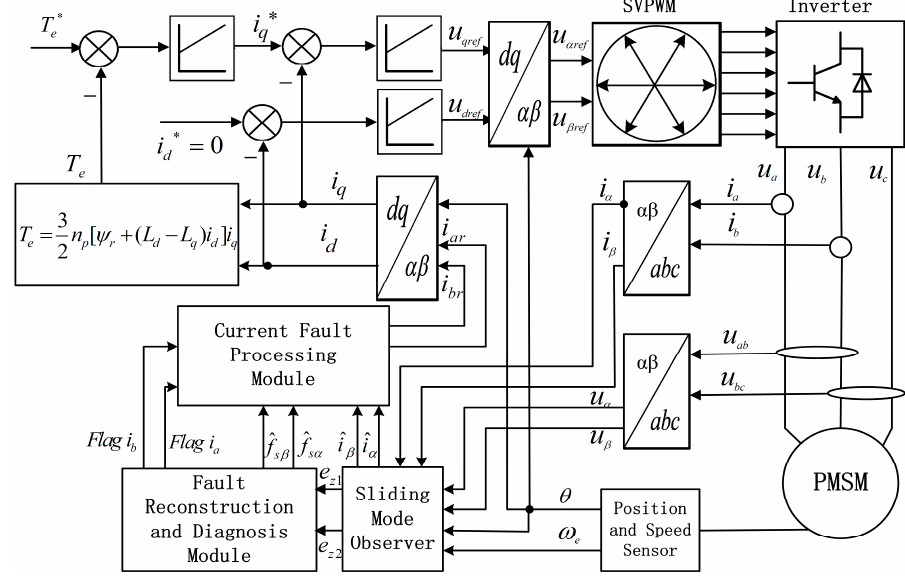
Figure 2. Block diagram of current sensor fault reconstruction and fault processing system for IPMSM.